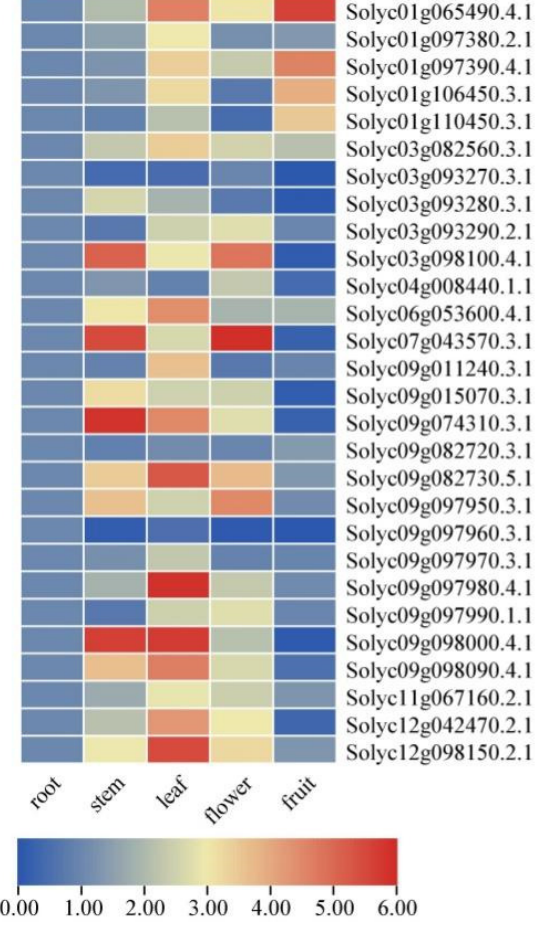
Figure 7. The expression levels of SlAKR genes in various organs of Solanum lycopersicum